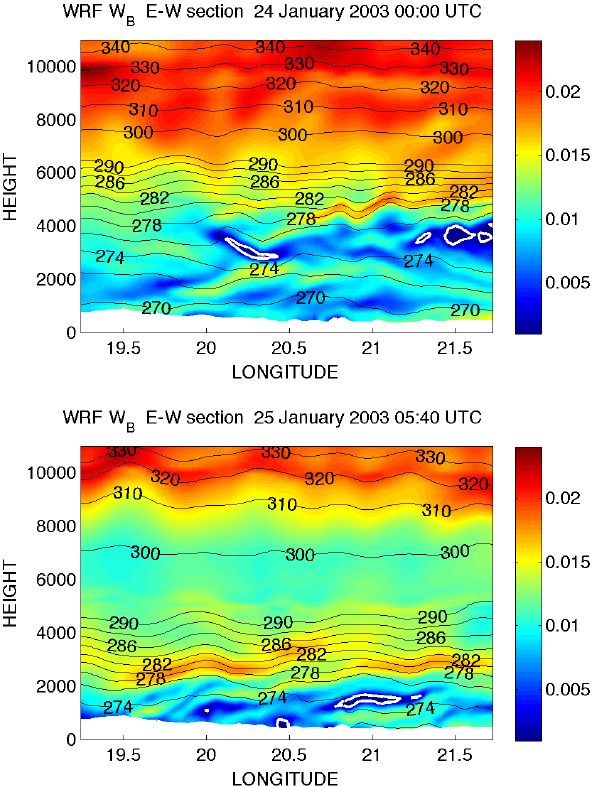
Fig. 12. Longitude-height cross sections of buoyancy frequency (colour scale, units s − 1 ) and potential temperature (black contours, units K). White contours enclose regions of convective instability, i.e. buoyancy frequency < 0. From the innermost model domain (1km horizontal grid) at the ESRAD latitude.